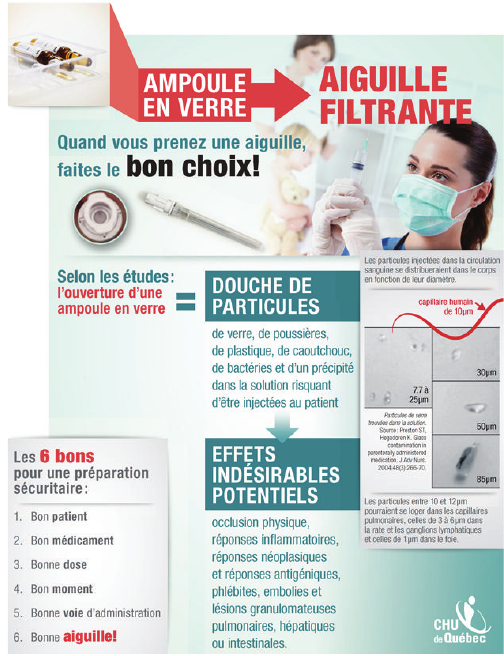
Figure 2: Poster for filter